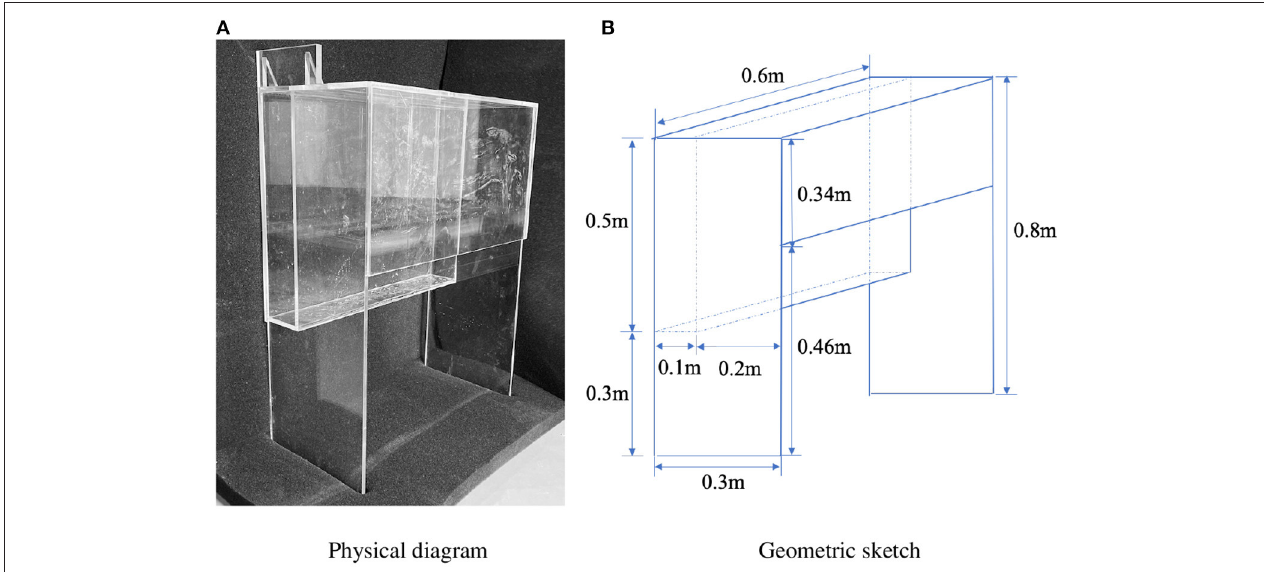
FIGURE 1 | Schematic of the oscillating water column (OWC) model. (A) Physical diagram (B) Geometric